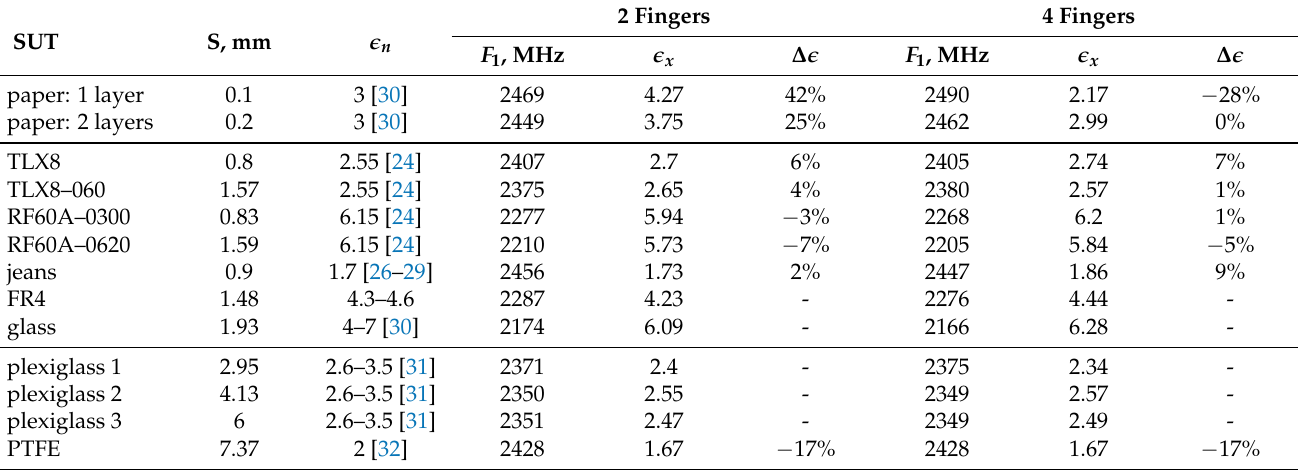
Table 7. The relative error comparison of the two best finger